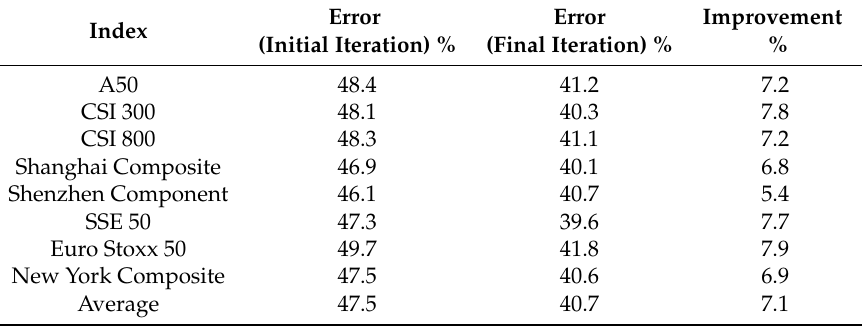
Table 4. Classification errors (up and down index movements) of the selection approach using neural